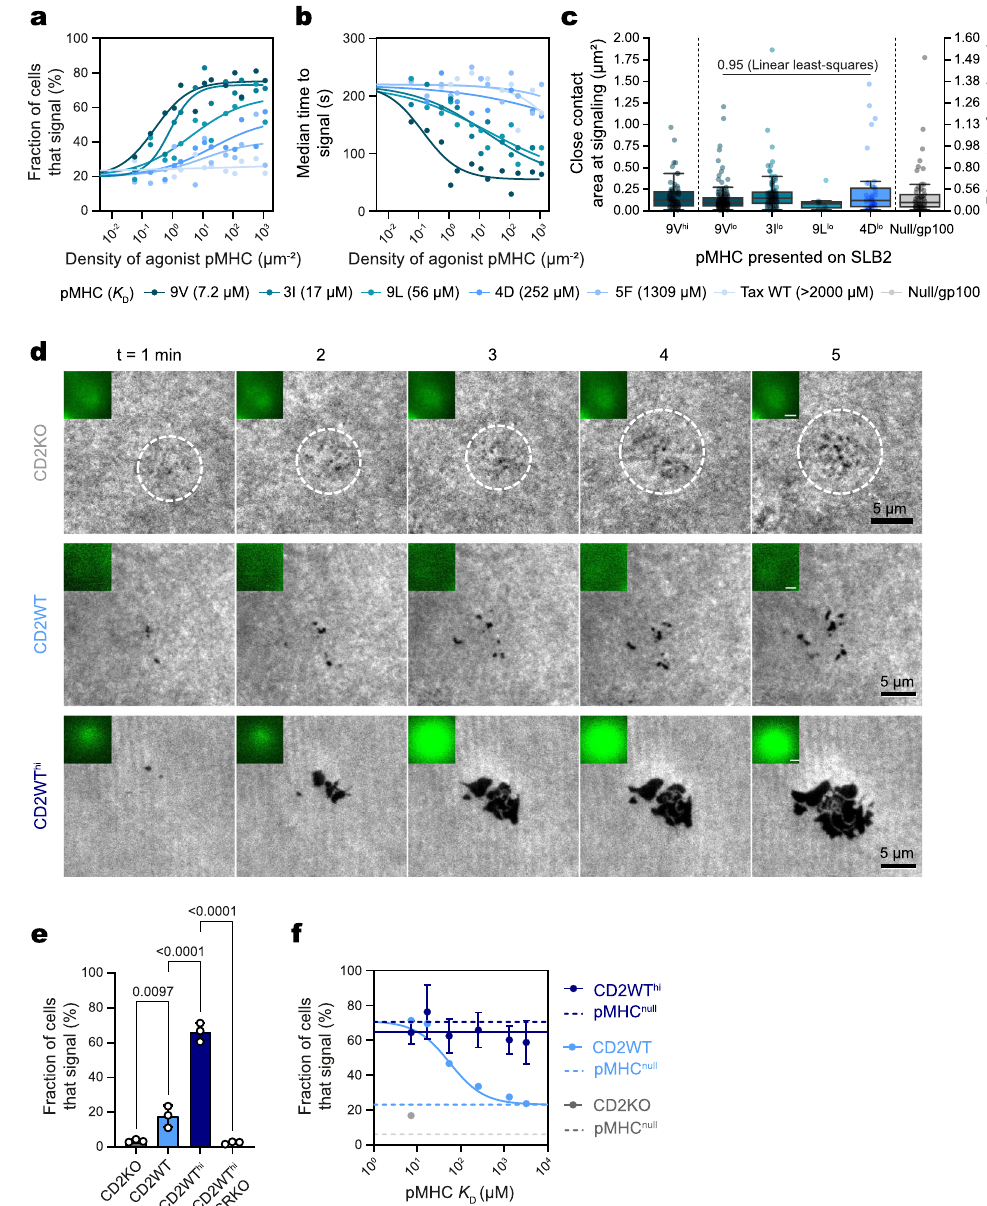
Fig. 6 | Antigen discrimination requires size-constrained close-contact formation. a Calcium response curves for J8-GECI cells interacting with SLB2s presenting pMHC null plus increasing densities of different-af fi nity pMHC. b Median time taken for cells to signal. From the same experiment as in ( a ). In a , b , each datapoint corresponds to a separate SLB; n =14 SLBs with ≥ 148 cells analyzed per SLB. Data were fi tted using a four-point dose-response curve, with the bottom of eachcurvein( a ),andtopofeachcurvein( b ),constrainedtoresponsesonanSLB2 presentingpMHC null . c Area(lefty-axis)anddiameter(righty-axis)ofclosecontacts formed by J8-GECI cells interacting with an SLB2 presenting pMHC null plus the indicatedagonist pMHCatpoint of calcium release; n =68 (9V hi , from 18cells),148 (9V lo , from 17 cells), 100 (3I lo , from 16 cells), 9 (9L lo , from 5 cells), 42 (4D lo , from 7 cells), and 58 (Null/gp100, from 11 cells) individual contacts. Data obtained for pMHC null and pMHC 9V-hi/lo SLBs are from the same experiment as in Fig. 3b – e. To measure the correlation between the af fi nity of low-density pMHCand the contact size, a linear least-squares regression was performed, and the p -value shown. The